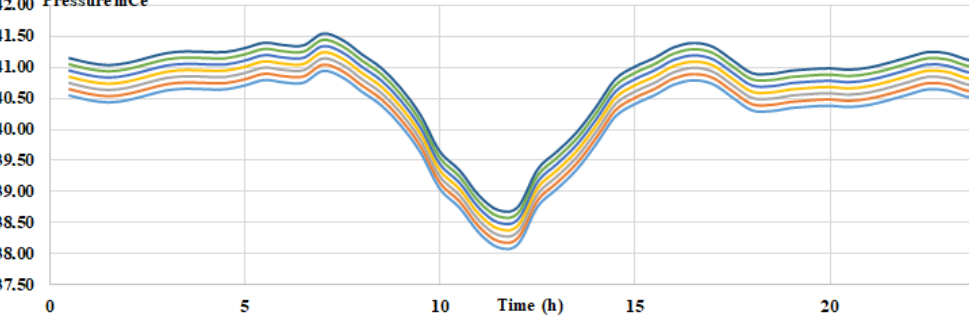
Figure 10. The reference pressures profile at P14.